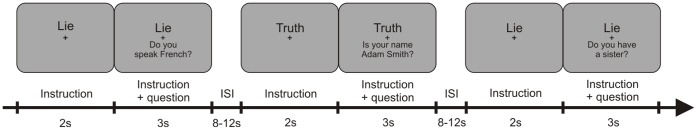
Experimental design of the study.The instruction was presented above the fixation point and, after 2 seconds, was followed by a question that appeared below the fixation point for 3 seconds. The inter-stimulus interval was varied from 8–12 s (for details see text).